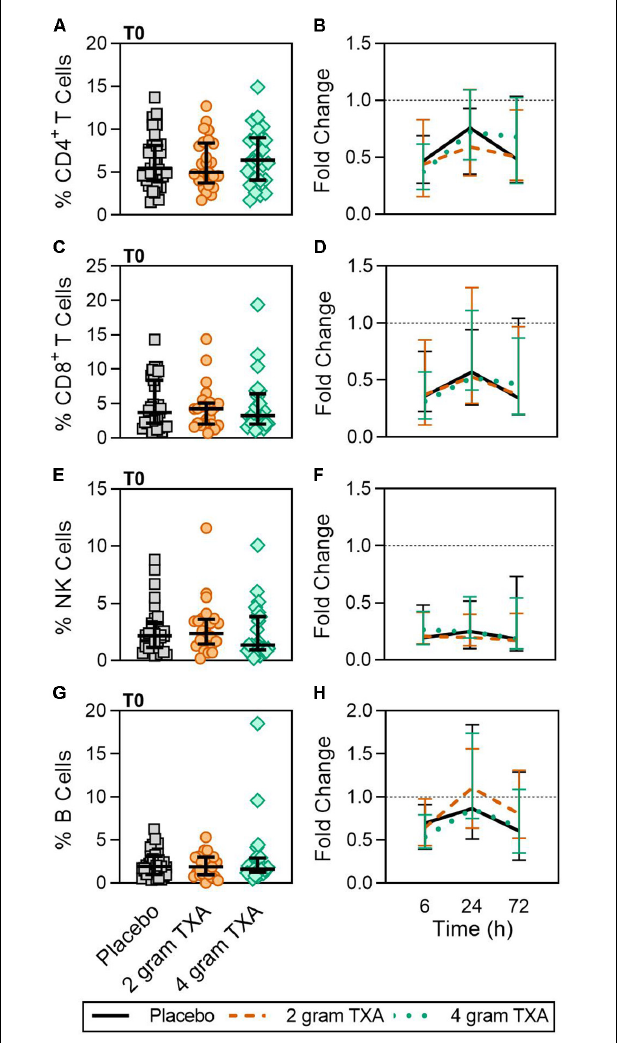
FIGURE 4 | Traumatic injury, not TXA, decreases circulating lymphoid populations. For T0, data are represented as individual points with median + IQR for error bars. For all kinetic data, fold change was calculated as [(frequency/MFI/concentration of a given population/analyte at the given time | | T6,T24,T72| |) ÷ (frequency/MFI/concentration of the same population/analyte at T0)]. Data are displayed as line graphs (fold change, median + IQR). The dashed line placed at y = 1 represents T0, or baseline. Placebo, n = 29; 2 g TXA, n = 24; 4 g TXA, n = 25. Statistical differences between the 4 g TXA and placebo groups at each given time point, as calculated via Kruskal–Wallis, are noted as follows: p > 0.05, not significant and not denoted on the graphical representation. (A) The frequency of CD4 + T cells found in total peripheral blood leukocytes at T0 in all three treatment groups. (B) Fold change in frequency of CD4 + T cells found in total peripheral blood leukocytes over the study period of 72 h. (C) The frequency of CD8 + T cells found in total peripheral blood leukocytes at T0 in all three treatment groups. (D) Fold change in frequency of CD8 + T cells found in total peripheral blood leukocytes over the study period of 72 h. (E) The frequency of NK cells found in total peripheral blood leukocytes at T0 in all three treatment groups. (F) Fold change in frequency of NK cells found in total peripheral blood leukocytes over the study period of 72 h. (G) The frequency of B cells found in total peripheral blood leukocytes at T0 in all three treatment groups. (H) Fold change in frequency of B cells found in total peripheral blood leukocytes over the study period of 72